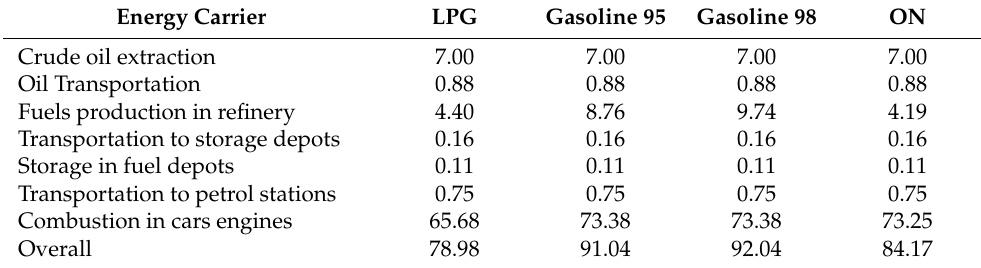
Table 3. Life-cycle GHG emissions from motor fuels in the reference case [gCO2-eq/MJ].